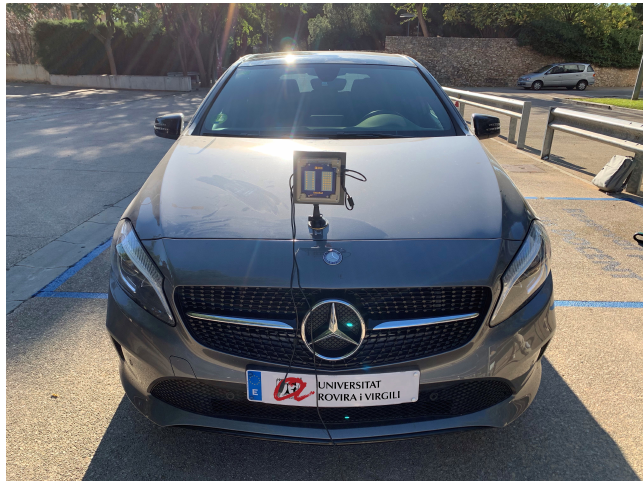
Figure 8. Photography of the car with the radar mounted.